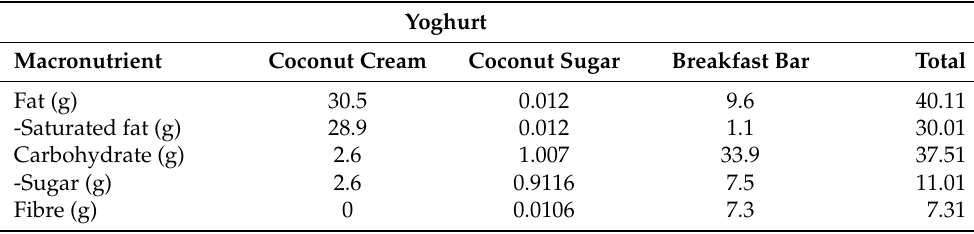
Table 1. Macronutrient content of study meal. Details of the yoghurt formulation in Section 2.2.